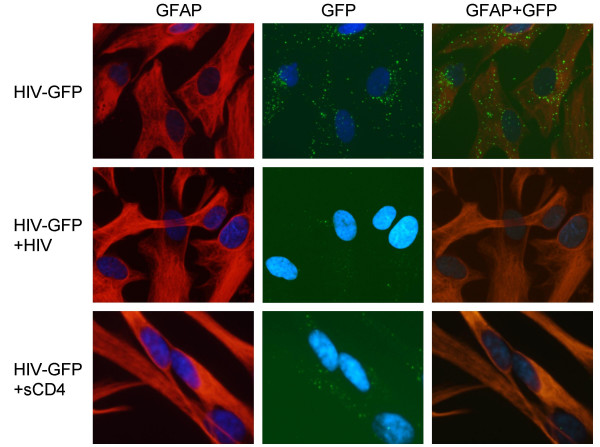
Extent and specificity of HIV-1 binding to HFA. Primary HFA were exposed for 1 h at 4°C to NL4-3 carrying GFP-Vpr alone (first row), in the presence of excess unlabeled NL4-3 (second row) or in the presence of soluble CD4 (third row). Cells were stained with anti-GFAP and a Texas Red-labeled secondary antibody to label astrocytes and with DAPI to visualize nuclei. Images of red and green fluorescence were superimposed (third column).